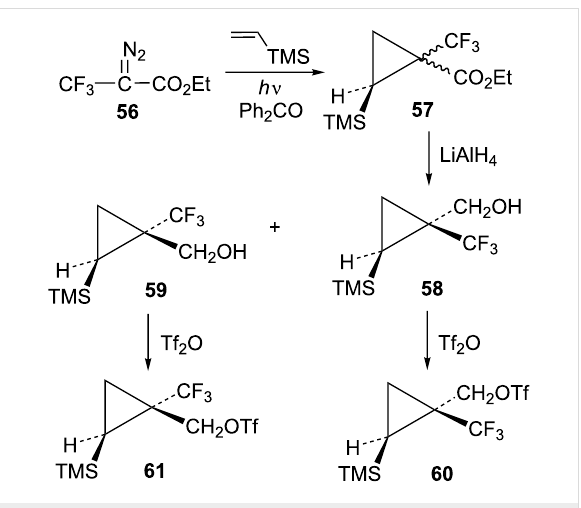
Scheme 12: Formation of triflates 60 and 61